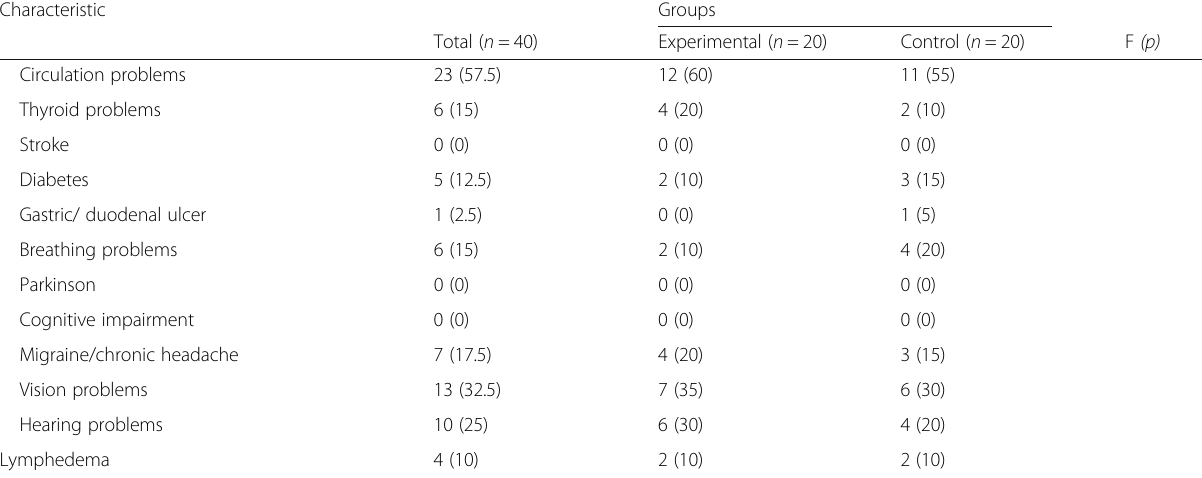
Table 1 Mean or number (%). Range (Min-Max) and ANOVA of demographic and clinical baseline characteristics of groups (Continued)